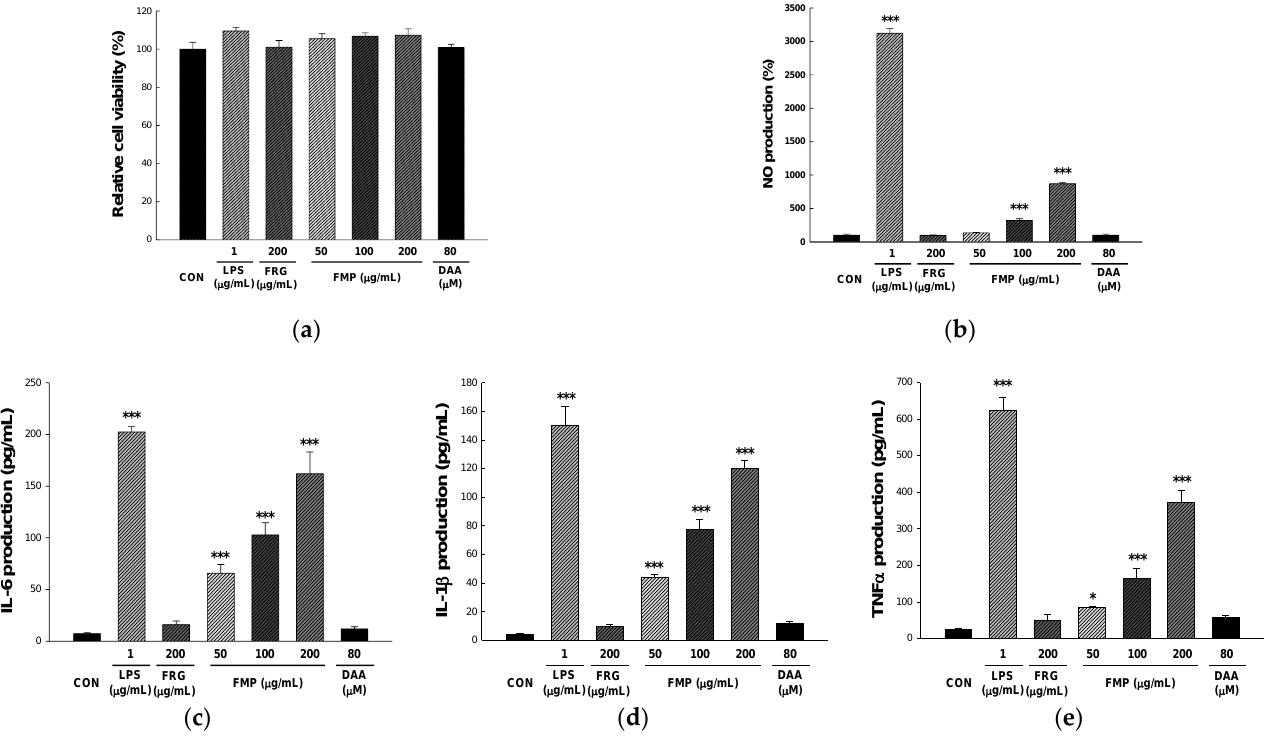
Figure 1. Effects of FMP on RAW 264.7 cell viability, NO production, and cytokine (IL-6, IL1 β , and TNF- α ) release in RAW 264.7 cells. The cells were incubated with FMP and DAA for 24 h. ( a ) Cell viability and ( b ) NO production were determined using an XTT assay and Griess reagent assay, respectively. ( c ) IL-6, ( d ) IL-1 β , and ( e ) TNF- α production in RAW 264.7 cell culture supernatant was determined using an ELISA kit. All values are expressed as the mean ± standard deviation. * p < 0.05 and *** p < 0.001 vs. no treatment group. LPS, lipopolysaccharides; FRG, fermented red ginseng extract; FMP, fermented M. citrifolia polysaccharide; DAA, deacetylasperulosidic